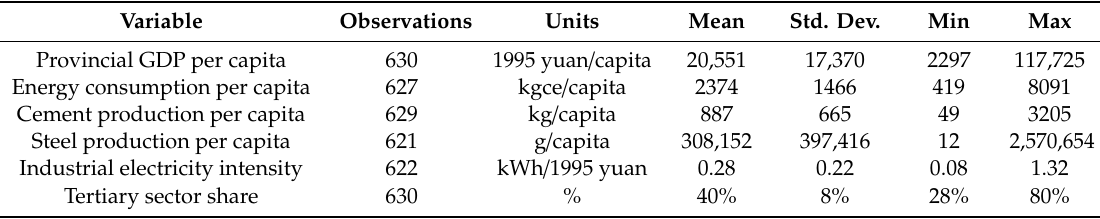
Table 2. Descriptive statistics of model